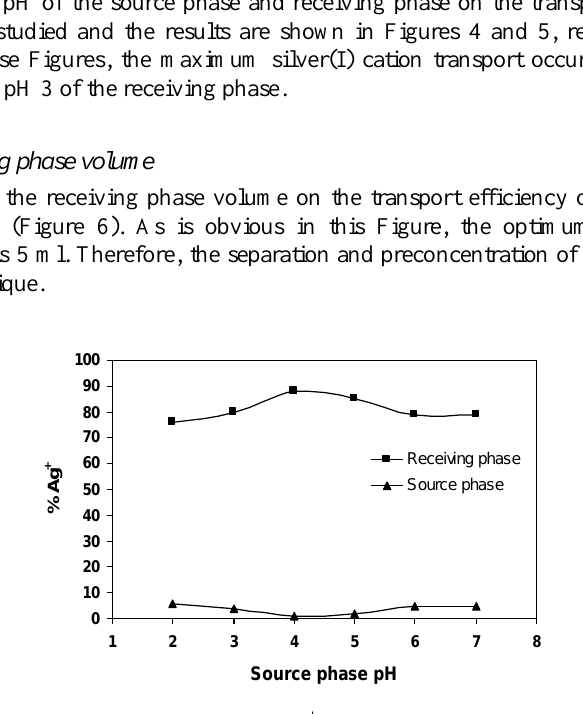
Figure 4. Effect of pH in source phase on Ag + cation transport. Experimental conditions: source phase, 10 ml of 3.0×10 -4 M Ag + cation and 3.0×10 -3 M picric acid with various pH; liquid membrane phase, 50 ml of 1.0×10 -3 M carrier in DCM; receiving phase, 5 ml of 1.0×10 -3 M S O 32- at pH 3; time of transport, 4 hours. 2